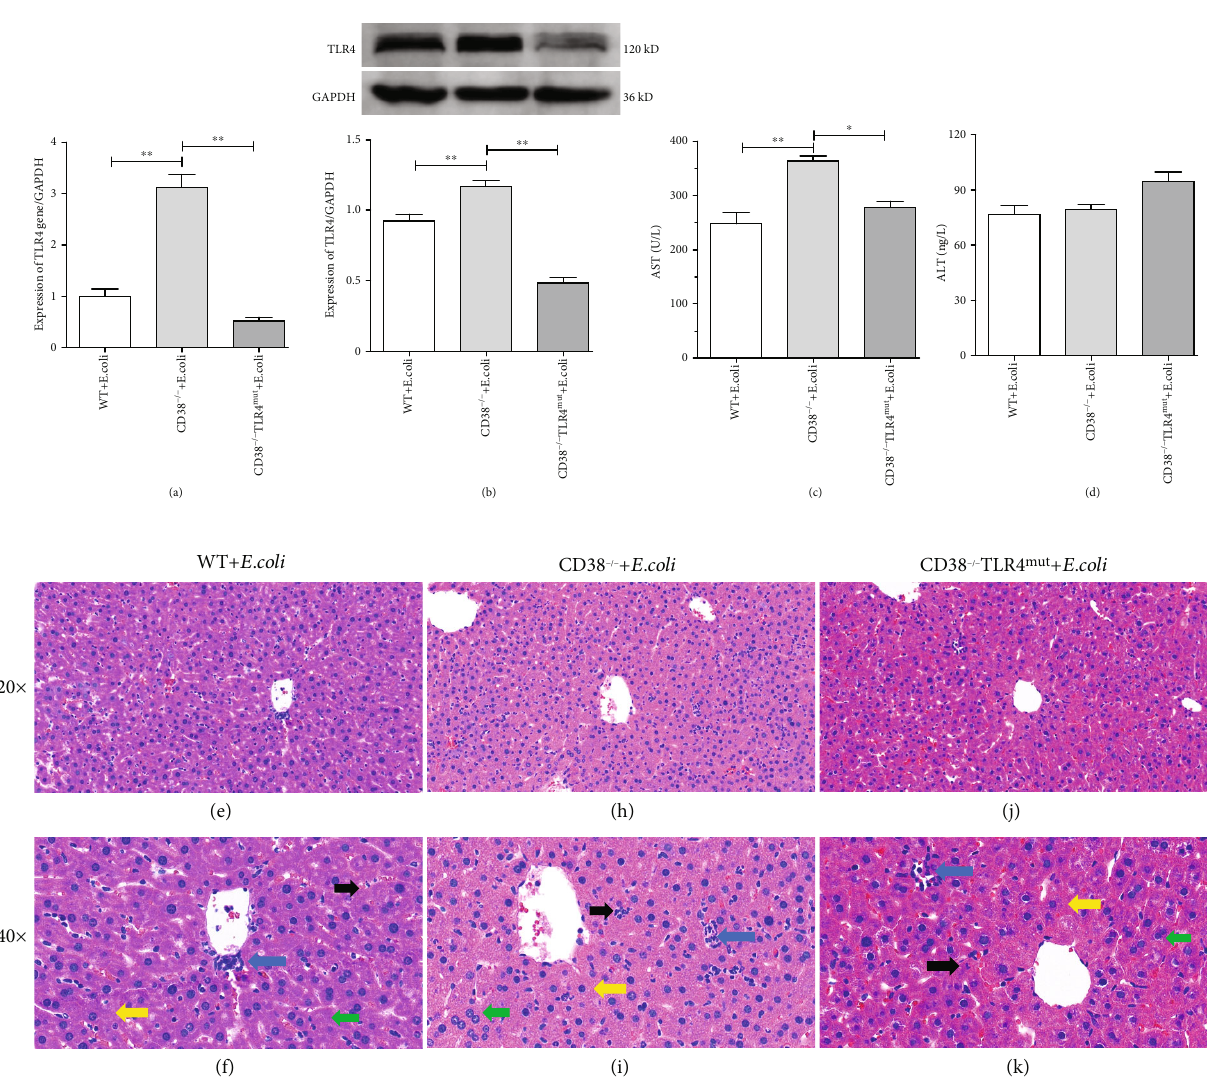
Figure 2: Escherichia coli can induce more serious liver injury in CD38 -/- mice. The equivalent amount of E. coli suspension was injected intraperitoneally into WT, CD38 -/- , and CD38 -/- TLR4 mut mice, and the liver and serum samples were harvested after 3 hours. The mRNA of TLR4 (a) in the liver was measured by RT-qPCR, and the expression of TLR4 (b) was detected by Western blot. The concentrations of AST (c) and ALT (d) in serum were determined by using the detection kits. And the liver samples were taken for hematoxylin and eosin staining (e, f, h, i, j, k). The yellow arrows indicate edema, the blue arrows indicate in fl ammatory cell in fi ltration, the black arrows indicate punctate necrosis, and the green arrows indicate binucleate hepatocytes. Data are presented as means ± standard deviation . Statistical signi fi cance was determined by one-way ANOVA ( n = 3 , ∗ p < 0 : 05 , ∗∗ p < 0 : 01